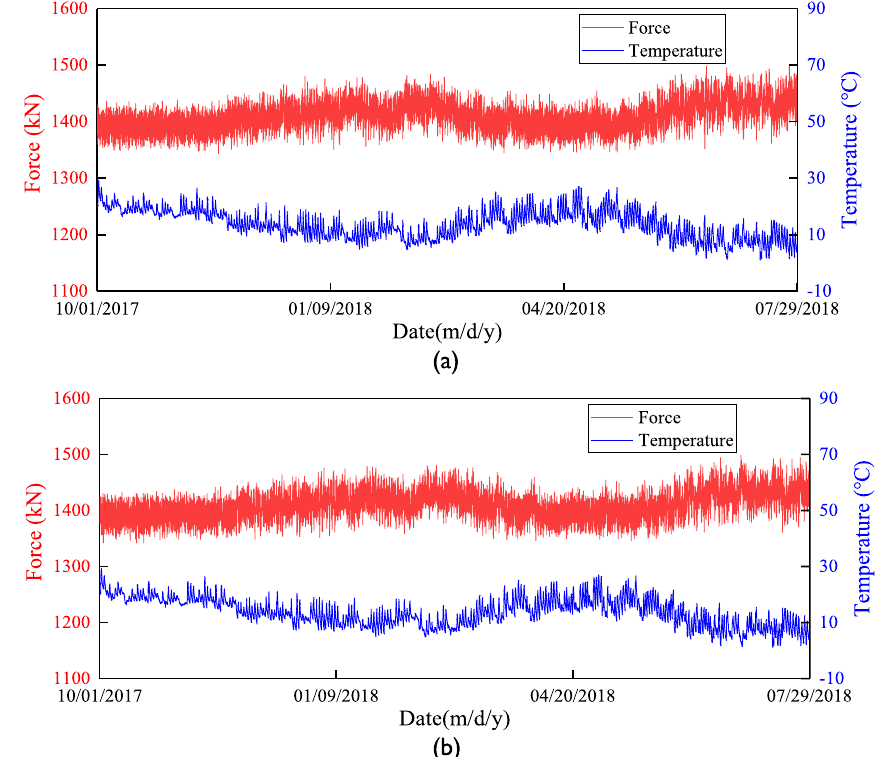
Fig. 7 The monitored result (from October 1, 2017 to July 29, 2018): a for the suspender C1, and b for the suspender